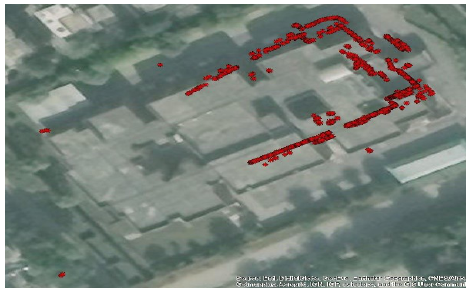
Figure 11. Overlaid point cloud